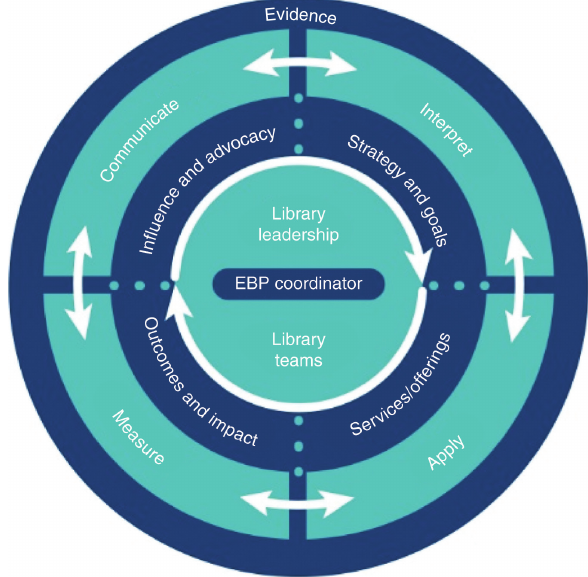
Fig. 1: Evidence-based practice at USQ Library (Howlett & Thorpe,